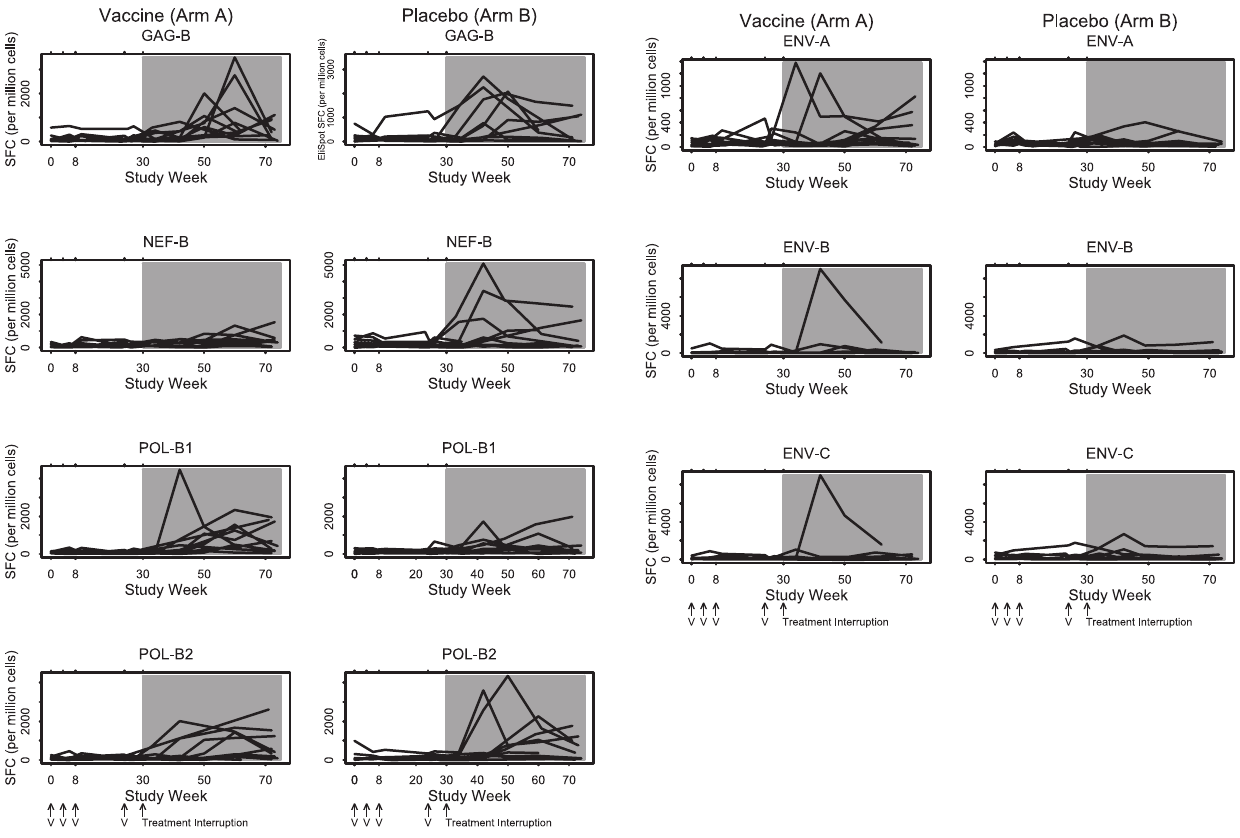
Figure 4. CD8 IFN-- c ELISPOT profile by antigen and treatment arm. Antiretroviral therapy was discontinued at study week 30. Positive responses were defined as a 2-fold increase from baseline that were also $ 100 spot forming cells (SFC) per million PBMC. The symbol V indicates when vaccine or placebo was administered. The shaded area indicates the time period when subjects were off antiretroviral therapy.